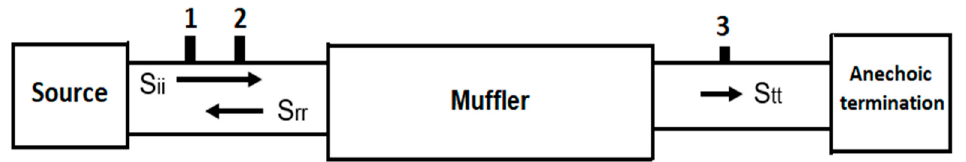
Figure 1. Measurement set-up according to the decomposition theory.